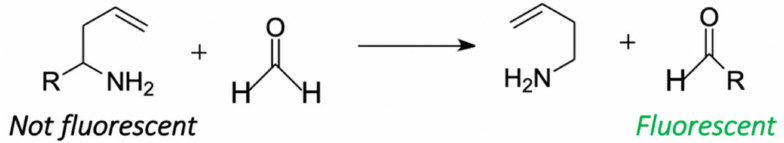
Figure 9. FA in 2-aza-Cope regrouping. R denotes probes for FA